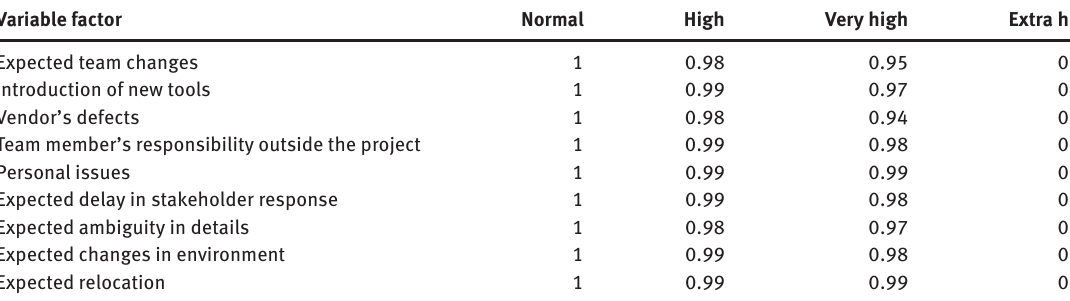
Table 3: Dynamic Force